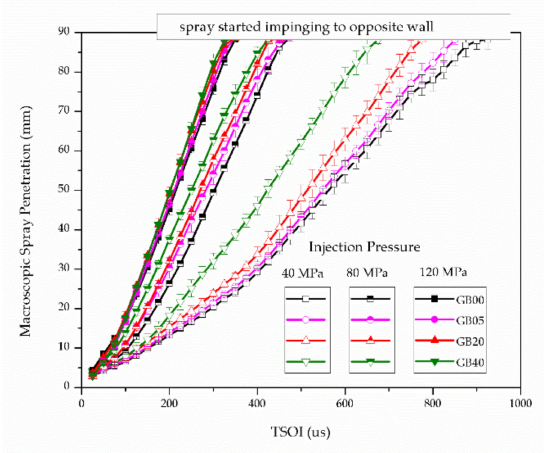
Figure 12. Macroscopic spray penetration of GB fuels according to the injection pressure (GB00: gasoline 100% and biodiesel 0%, GB05: gasoline 95% and biodiesel 5%, GB20: gasoline 80% and biodiesel 20%, GB40: gasoline 60% and biodiesel